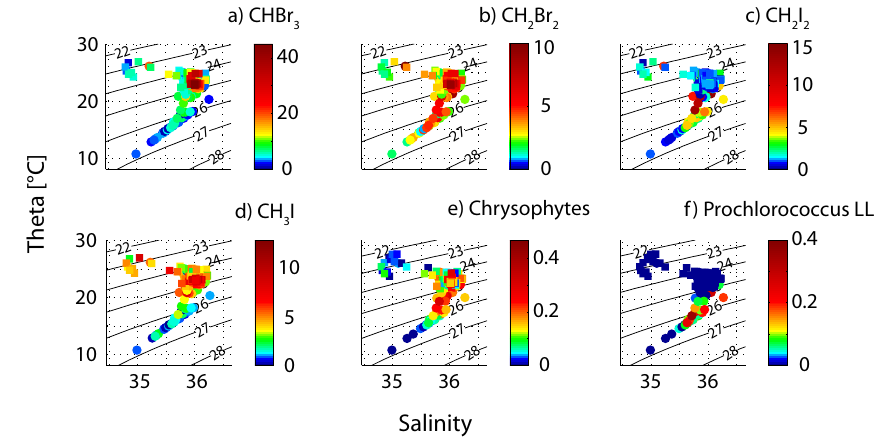
Figure 4. (a–d) Temperature–Salinity (T–S) plots for halocarbons (in pmol L − 1 ) and ( e–f ) phytoplankton species (in µg Chl a L − 1 ) . Square markers indicate surface values of halocarbons from underway measurements, circles are depth measurements from CTD profile, and the lines indicate the potential density –